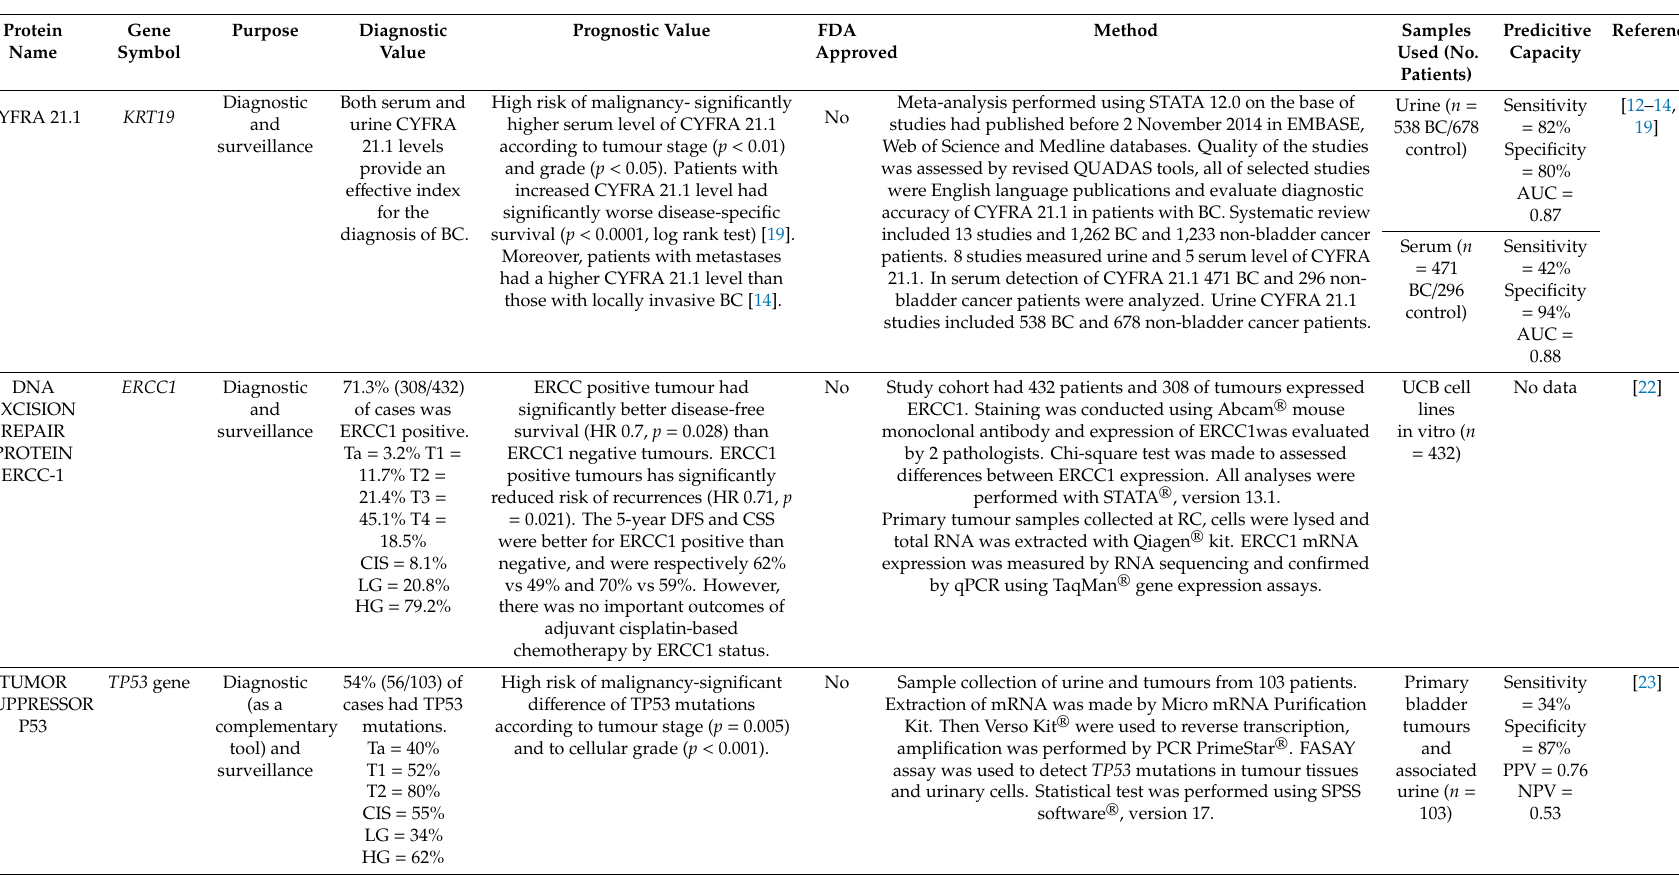
Table 1. Predictive capacity of bladder cancer